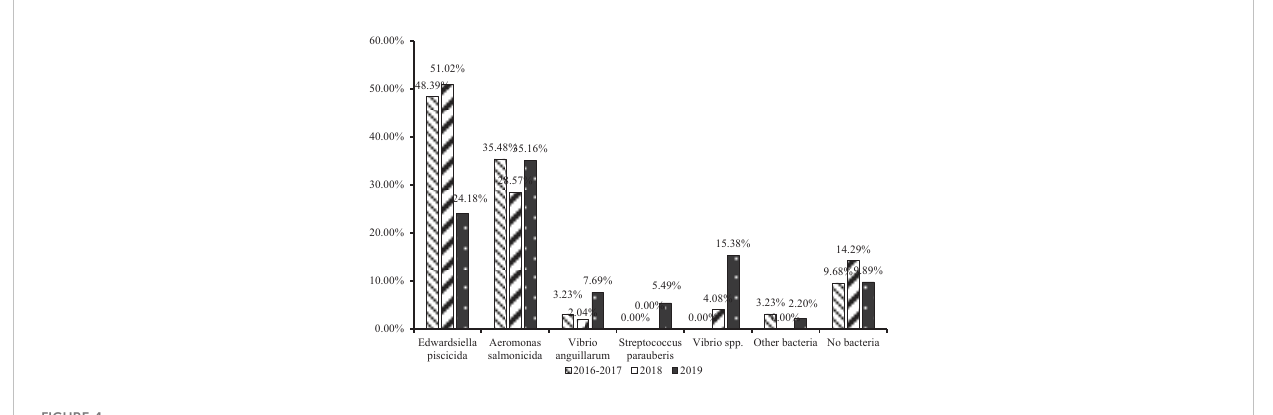
FIGURE 4 Comparison of disease etiologies of turbot farm cases between 2016-2019.